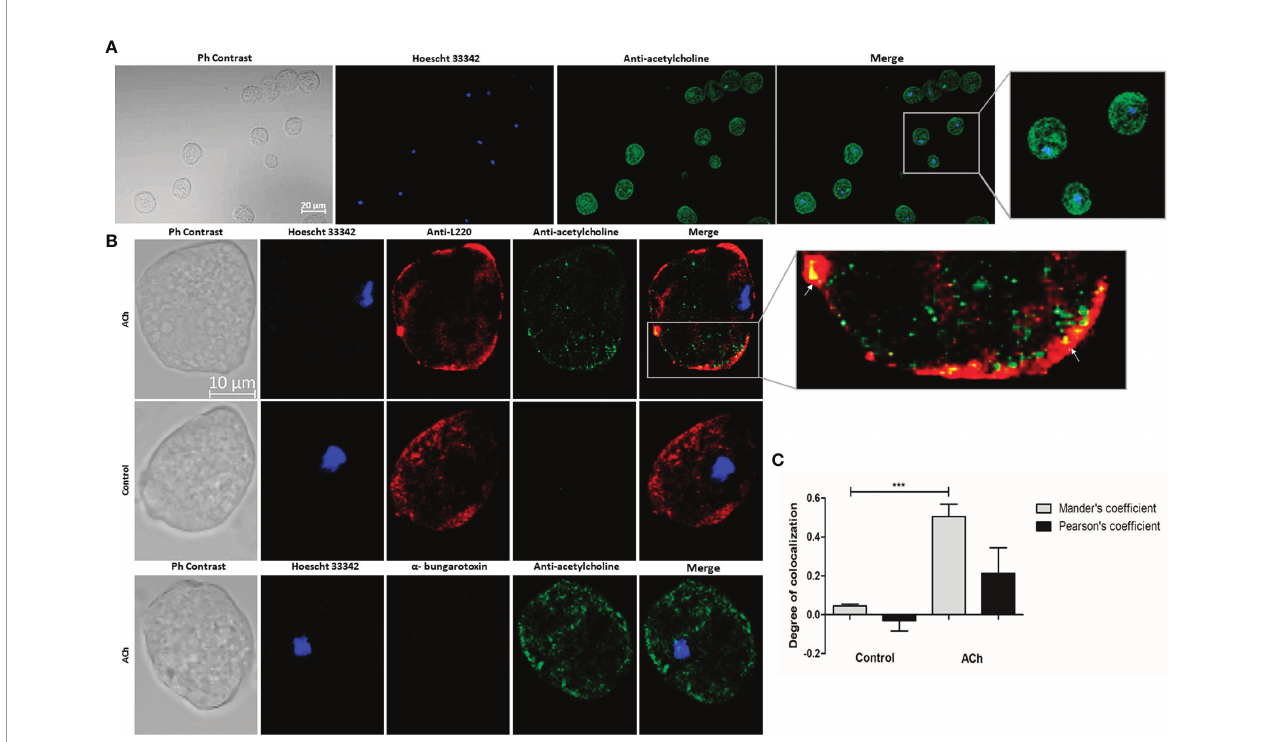
FIGURE 2 | Acetylcholine binding on E. histolytica membrane. (A) Trophozoites treated with 1 µM ACh for 1 h were fi xed and permeabilized. For immunodetection, anti-acetylcholine-FITC (green) antibody (1:800 dilution) and Hoechst 33342 (blue) for nuclear staining were used. Images were obtained by confocal microscopy at X20. (B) Cellular location of ACh and L220 (as a surface marker) on E. histolytica trophozoites membrane by using anti-acetylcholine-FITC (green) antibody (1:800 dilution), and an anti-L220 (red) antibody (1:500 dilution). Additionally, a -bungarotoxin-Alexa Fluor 647 (1:100) was also used. Nuclei were counterstained with Hoechst 33342 (blue). Representative images of the confocal microscopy analysis at X63. (C) Colocalization between ACh and L220 quanti fi ed and compared using Pearson ’ s and Mander ’ s correlation coef fi cients (considering as signi fi cant R coef fi cients values above 0.6 threshold). Data correspond to the mean ± SEM of fi ve independent experiments (n = 5). The statistical analysis was performed with the one-way ANOVA and Tukey posttest method, where the values of ***p < 0.001 were considered signi fi